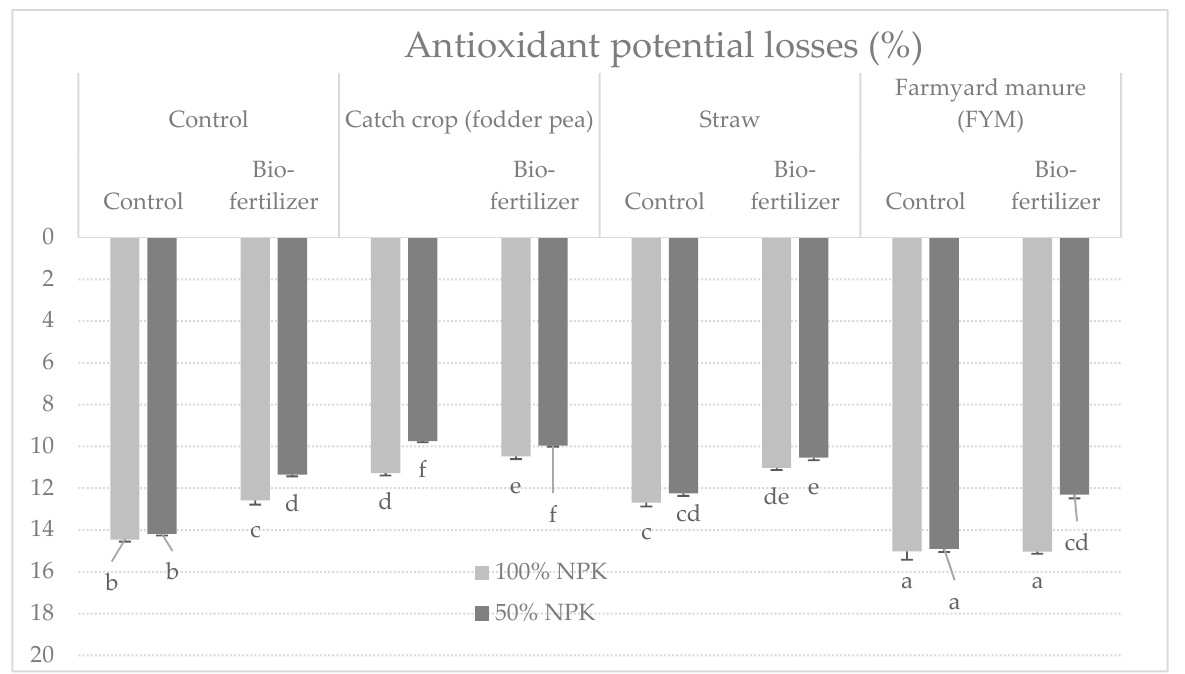
Figure 4. Percentage changes in antioxidant potential FRAP in potato tubers after 6 months of storage depending on the tested factors (mean from 3 years storage seasons). a, b, c, d…: means noted with the same letter are not significantly different ( p < 0.05).